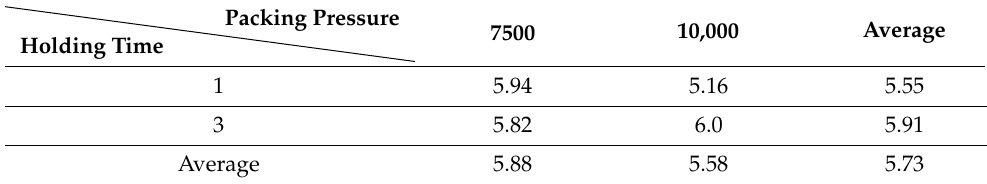
Table 6. The effect of packing pressure on recovery speed.